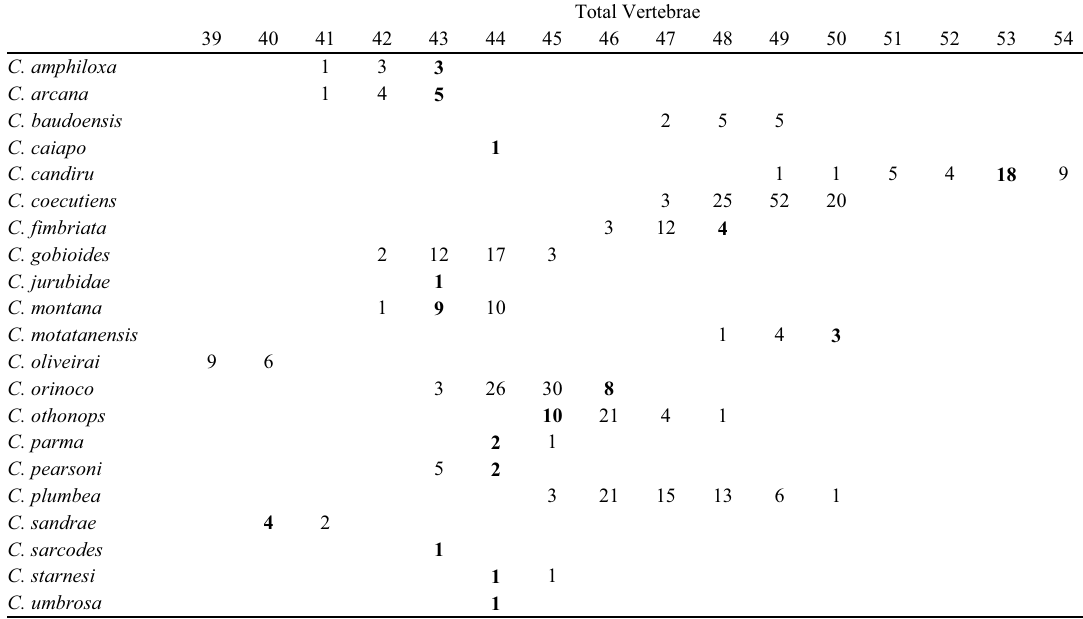
Table 15. Number of specimens of the species of Cetopsis with cited number of total vertebrae. Bold indicates value for holotype or lectotype when